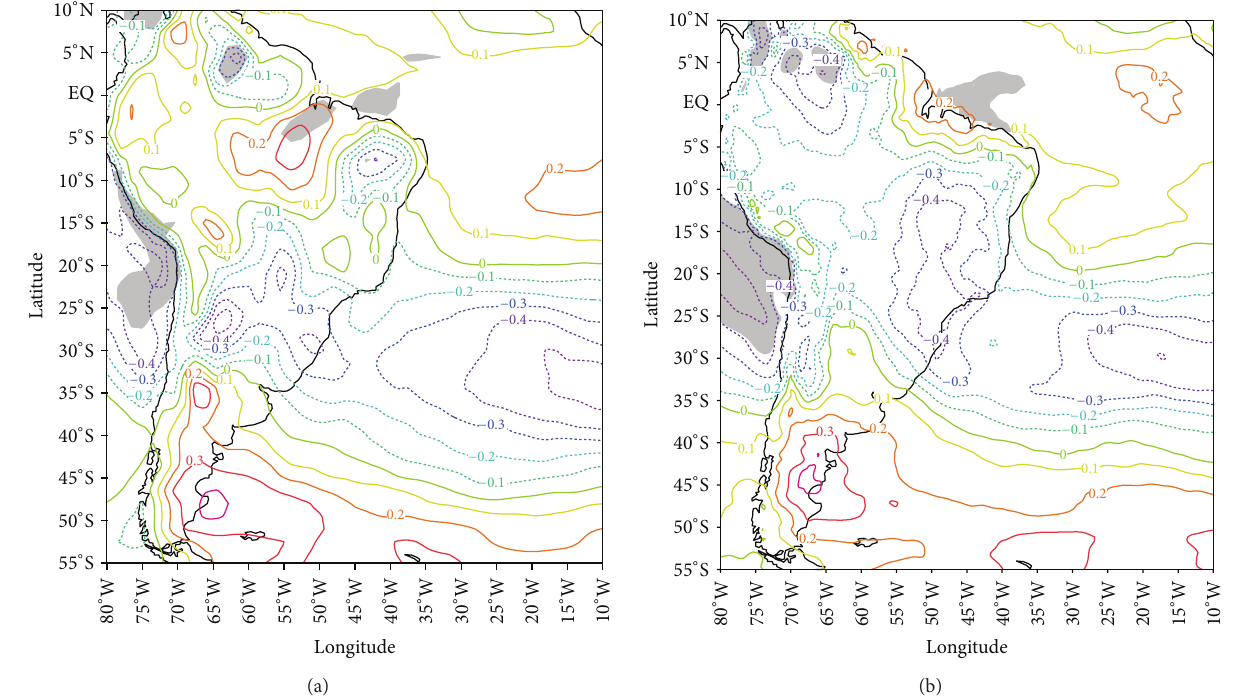
Figure 17: Annual mean temperature (K) anomaly at 925 hPa for HCSA poleward expansion cases in the period 1996–2011 based on the (a) Era-Interim reanalysis and (b) RegCM4 simulation. Contour intervals are 0.1 K and significant values above 90% confidence level from two-tailed Student’s 𝑡 -test are